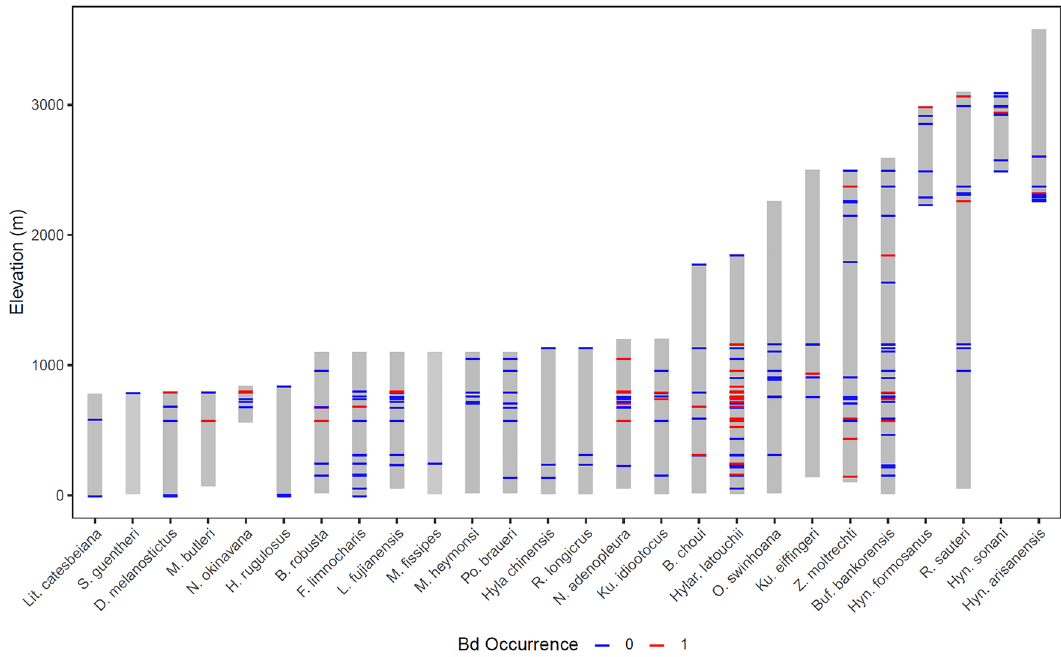
Figure 2. Bd occurrence by species and elevation. The grey bars represent the elevational range of a species. Horizontal lines show at which elevation the species was sampled and whether Bd was found in that species at that elevation (blue = 0, Bd does not occur; red = 1, Bd